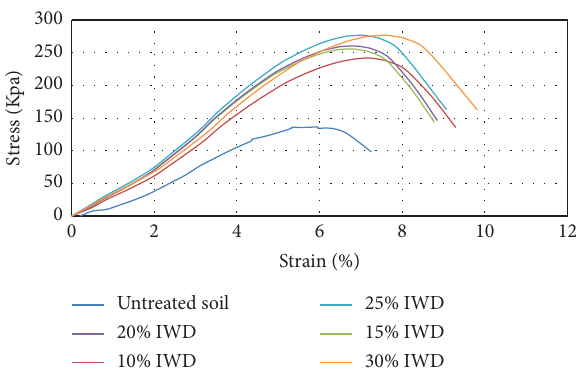
Figure 7: Efect of waste incineration bottom ash (WIBA) variation and 3-day curing time on weak subgrade soil.